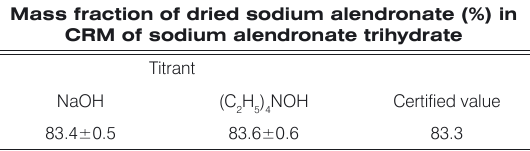
Table 2. Determination of sodium alendronate in pharmaceutical substance by acid-base